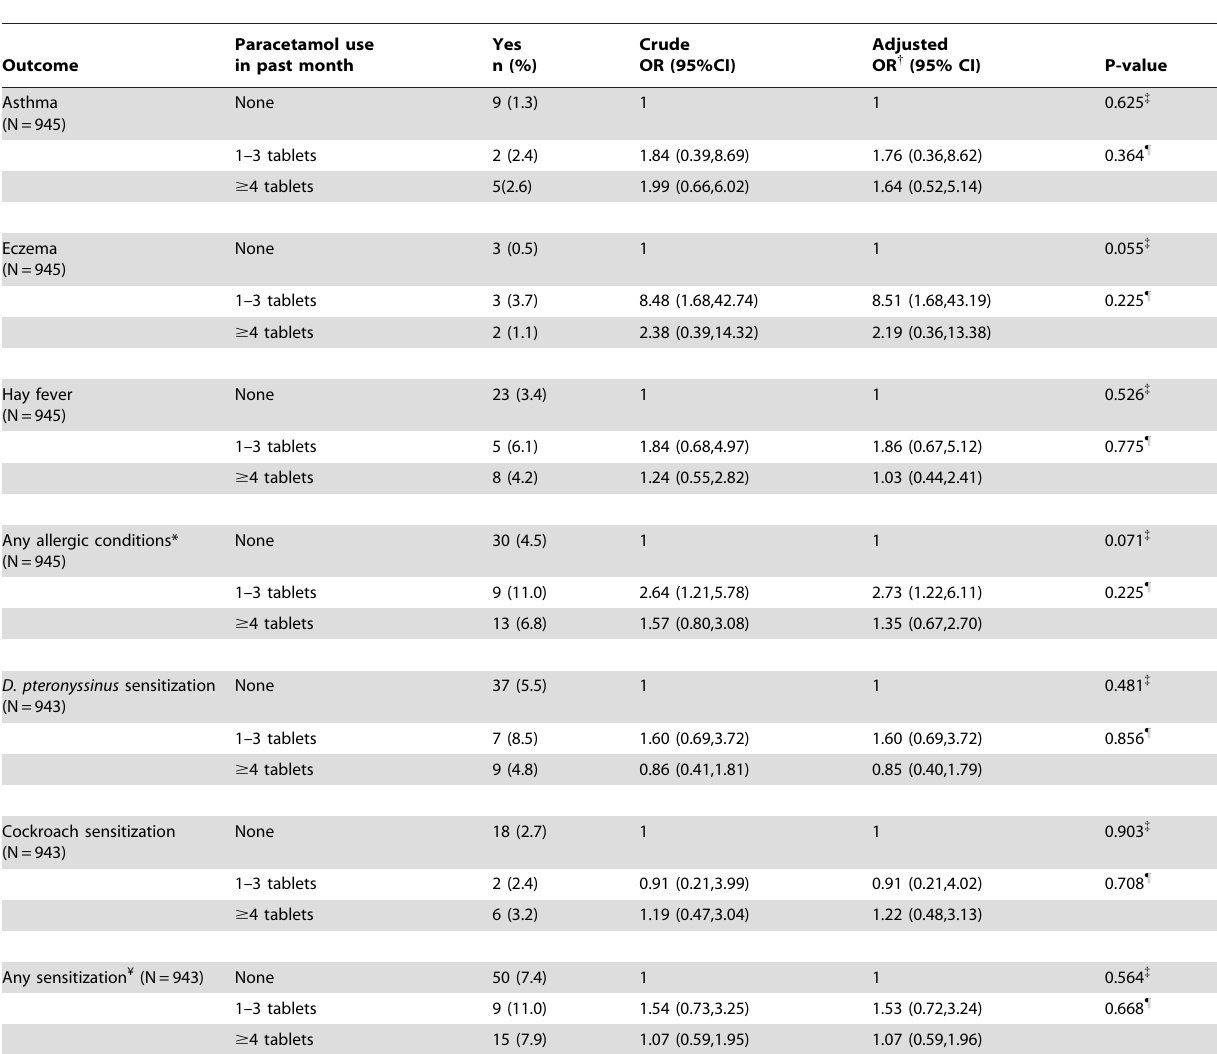
Table 3. OR for asthma, eczema, hay fever and sensitization in relation paracetamol use in the past month in women.